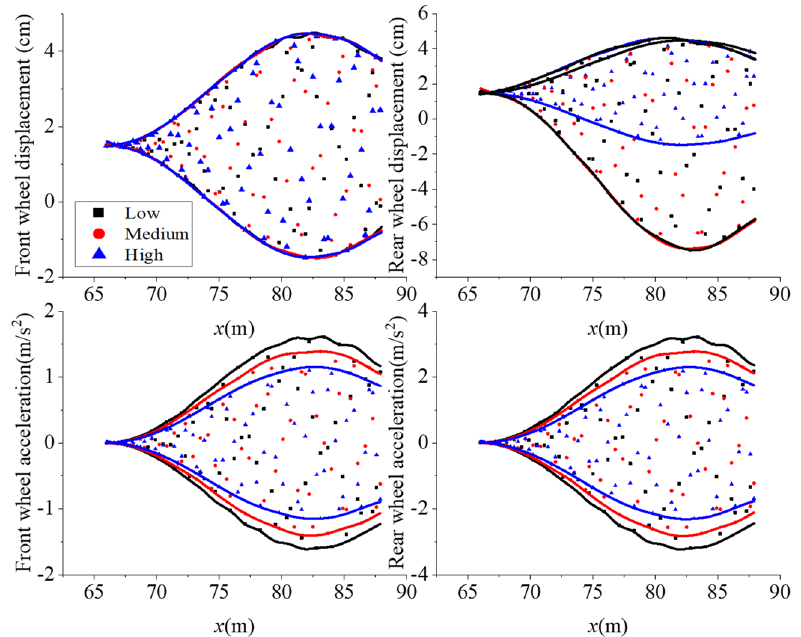
Figure 16. Net displacement and vertical acceleration 2 ns ≤ x ≤ 2 ns + ( b + c ) ( n ∈ N* ) (The black line is the envelope of scattered points at low stiffness ratio; the red line is the envelope of scattered points at medium stiffness ratio; the blue line is the envelope of scattered points at high stiffness ratio).